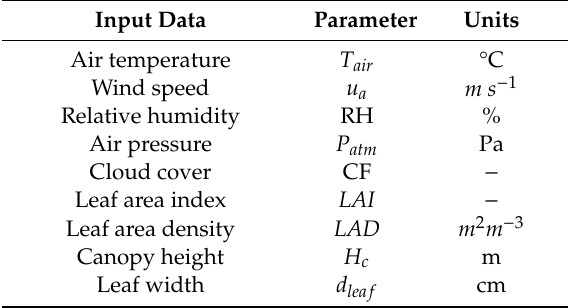
Table 1. Meteorological data and tree properties for input data.